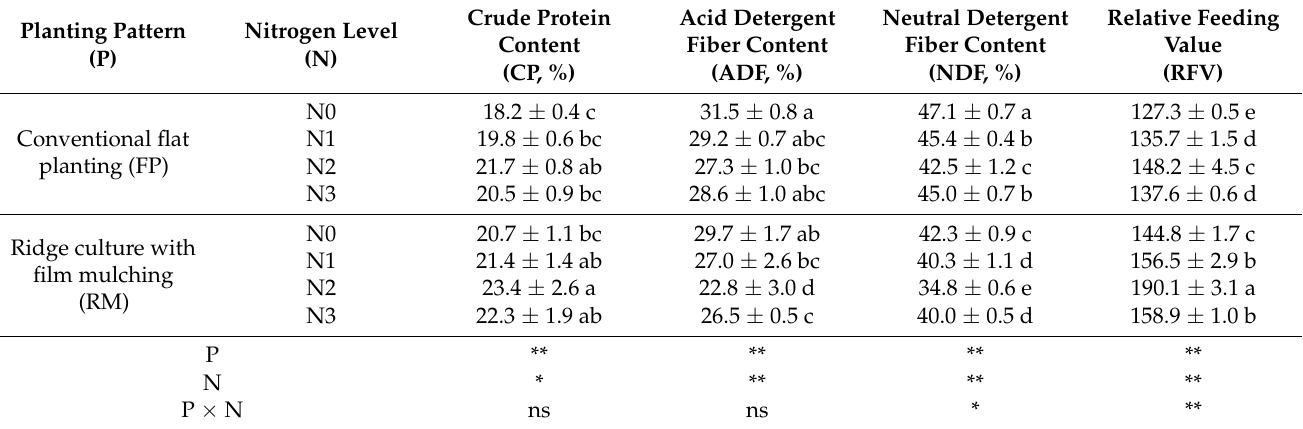
Table 4. Impact of planting pattern and nitrogen level on alfalfa quality.